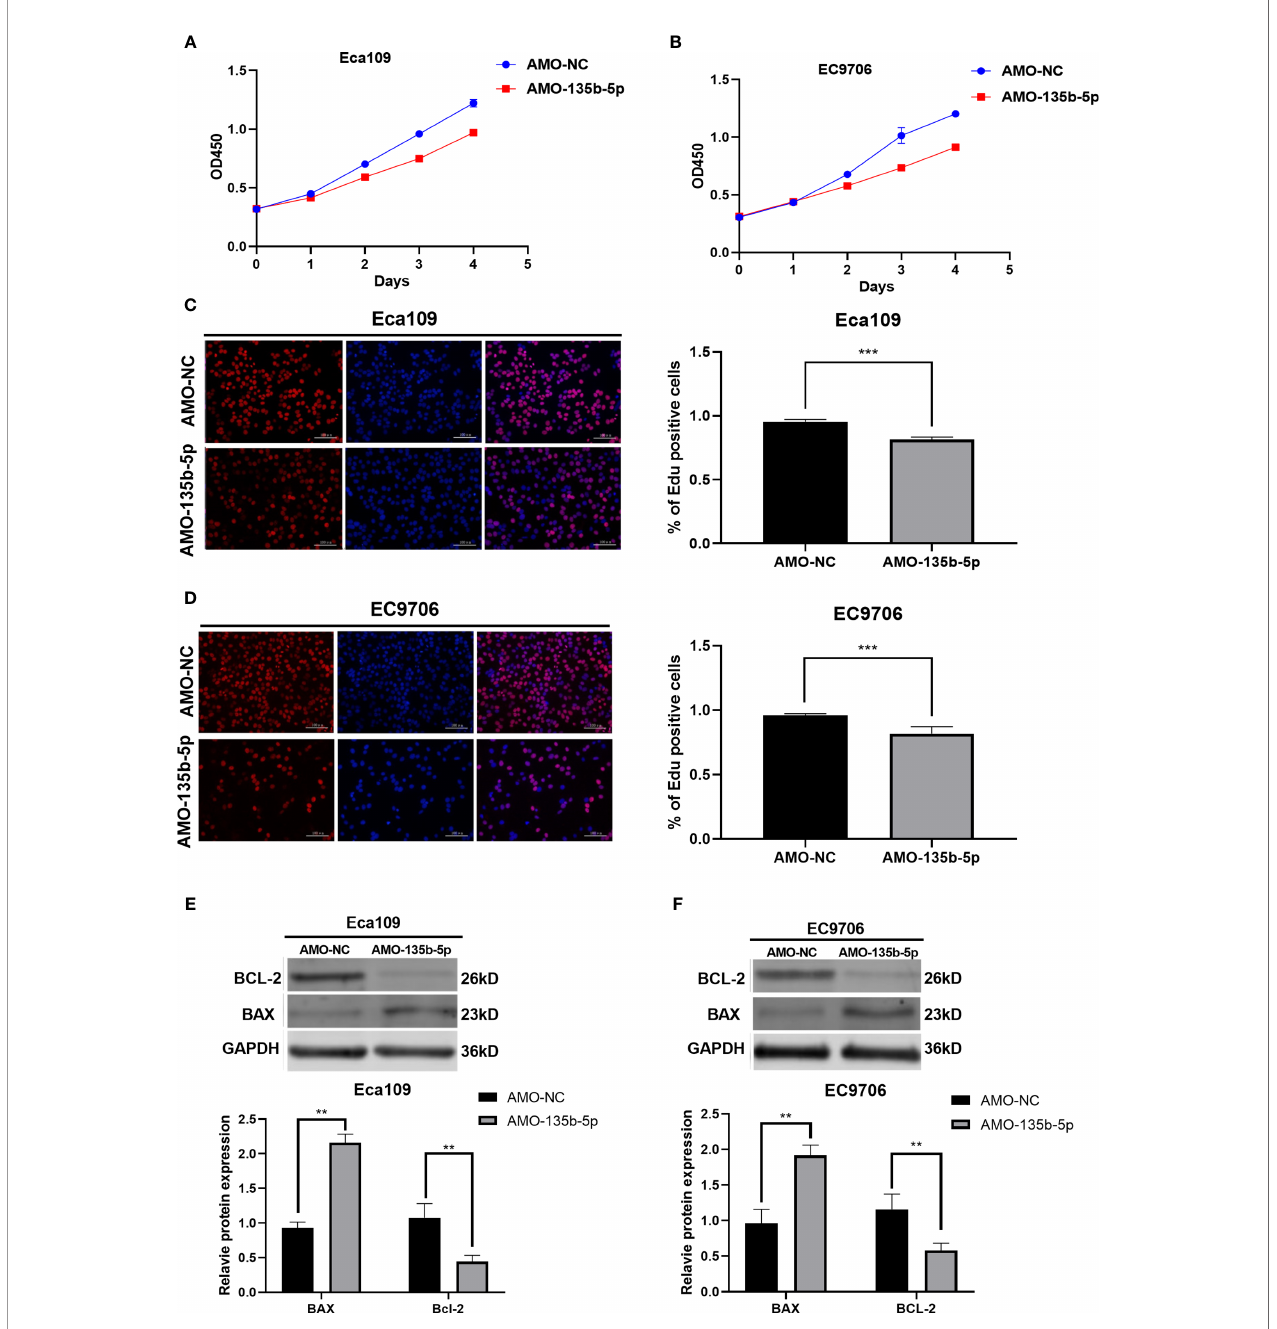
FIGURE 2 | Downregulation of miR-135b-5p affected viability, proliferation, and apoptosis in Eca109 and EC9706 cells in vitro . (A, B) CCK8 assay showed the cell viability after with transfected AMO-135b-5p or AMO-NC in Eca109 and EC9706 cells. (C, D) Cell proliferation was measured by Edu analysis. Edu (red), nuclear (Hoechest, blue), magni fi cation ×200. (E, F) The expression of Bax and Bcl-2 was showed by Western blot. Statistical analyses were showed accordingly. (**p < 0.01, ***p <